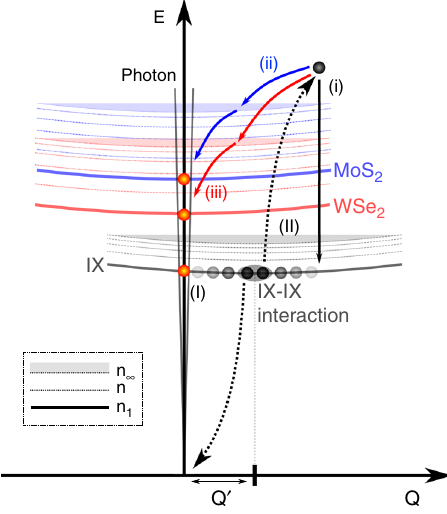
Fig. 4 Mechanism of upconverted emission in the two-particle picture. The solid lines represent the excitonic ground-state dispersion n 1 of the IX (gray), MoS 2 (blue) and WSe 2 (red). The circles stand for excitons. Q ′ is the momentum mismatch as de fi ned in Fig. 1a. The dashed lines indicate excited states n and the shaded area marks the excitonic continuum n ∞ . The gray-scale shading of circles schematically pictures the momentum distribution of excitons. A bright shading indicates less excitons for a given momentum than a dark shading. The photon dispersion is overlaid (gray lines) to mark the region of effective radiative recombination (orange circles). For the situation depicted, the bias voltage is below the threshold for direct intralayer charge injection. Mechanism (I) illustrates radiative IX emission facilitated by an increasing number of IX with large momenta. Mechanism (II) depicts excitonic Auger processes. The gray ellipse schematically highlights the interaction between two exemplary excitons. As a result of the interaction, one exciton recombines non-radiatively and transfers the energy to the other exciton (arrows with dotted